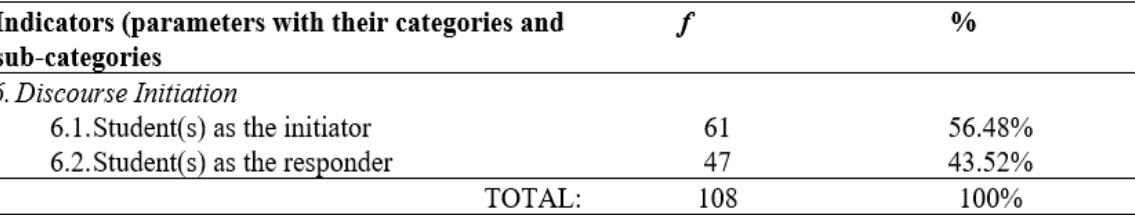
Table 7. Discourse Initiation as a Communicative Feature